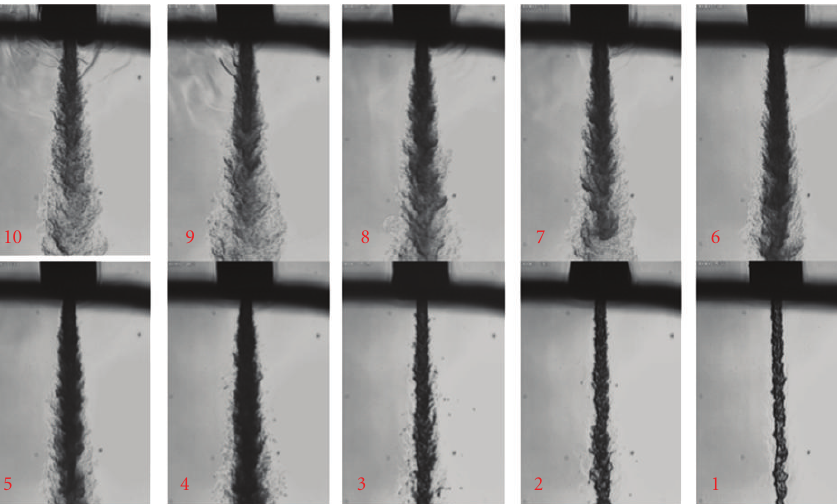
Figure 1: Back-illuminated images of a single nitrogen jet injected into nitrogen at a fixed supercritical temperature of 300 K but varying sub- to supercritical pressures (For N 2 : P critical = 3 . 39MPa; T c = 126 . 2K). From lower right to upper left: P ch /P critical (frame no.) = 0.23 (1), 0.43 (2), 0.62 (3), 0.83 (4), 1.03 (5), 1.22 (6), 1.62 (7), 2.44 (8), 2.74 (9). Reynolds’ number (Re) was from 25,000 to 75,000. Injection’